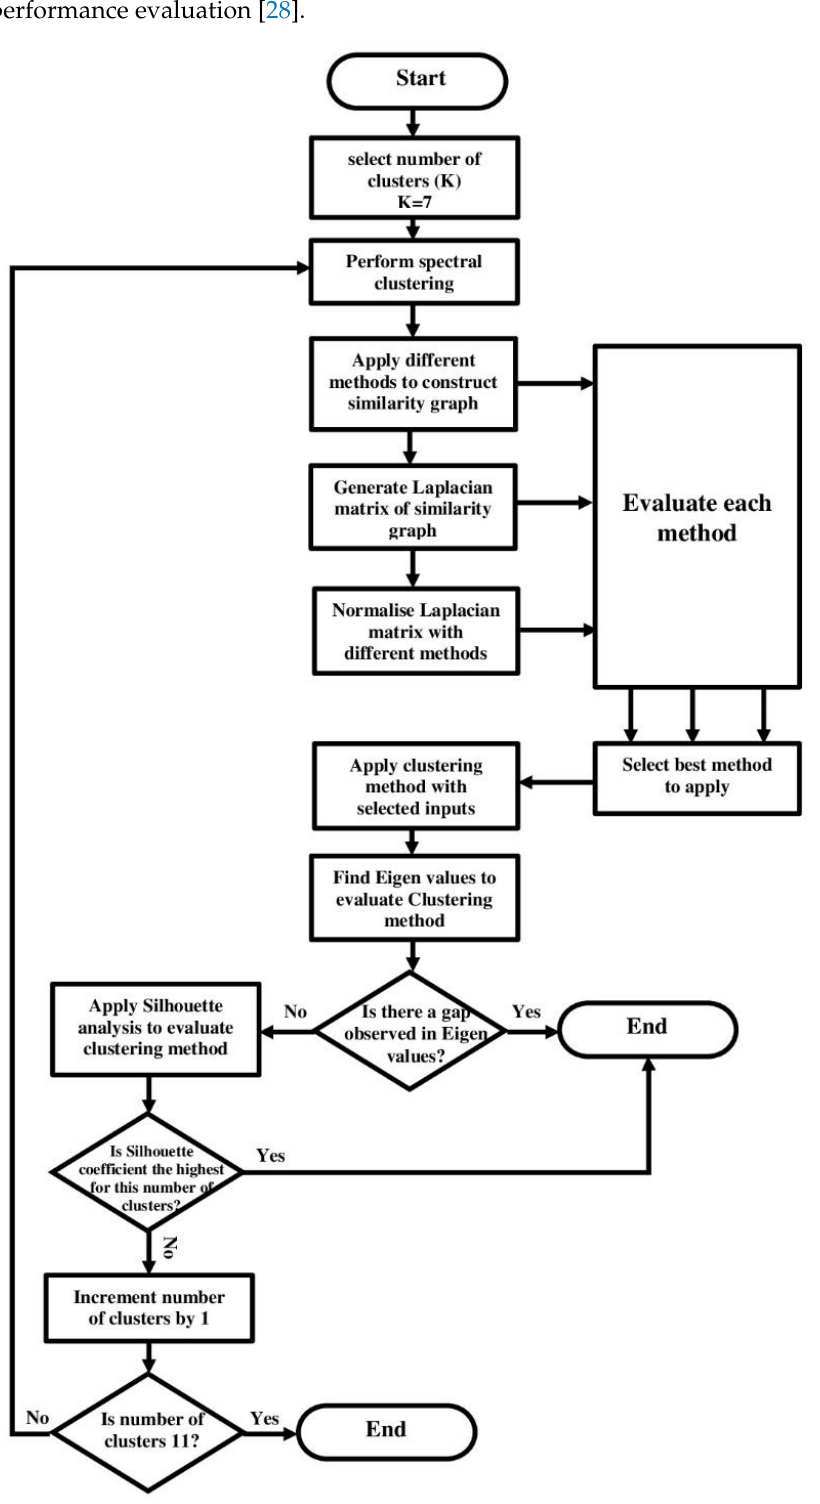
Figure 2. Architecture of the algorithm used to determine the proper number of clusters.